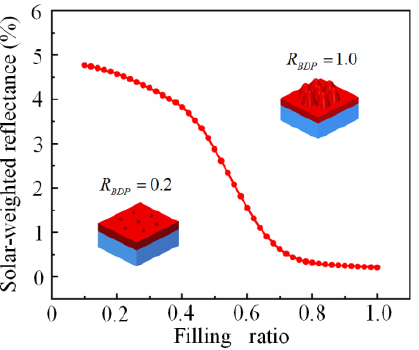
Figure 5. Curve of the solar-weighted reflectance with the filling ratio from 0.1 to 1.